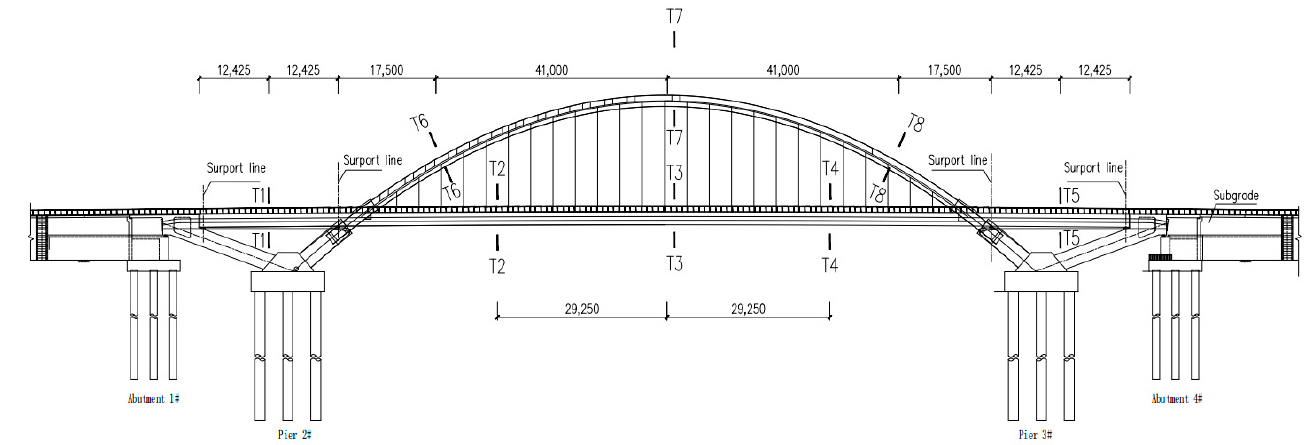
Figure 7. Temperature monitoring section of the bridge (unit: mm).